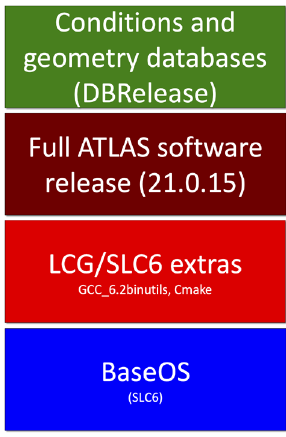
Figure 1. The image production pipeline adds each layer on top of pre-existing